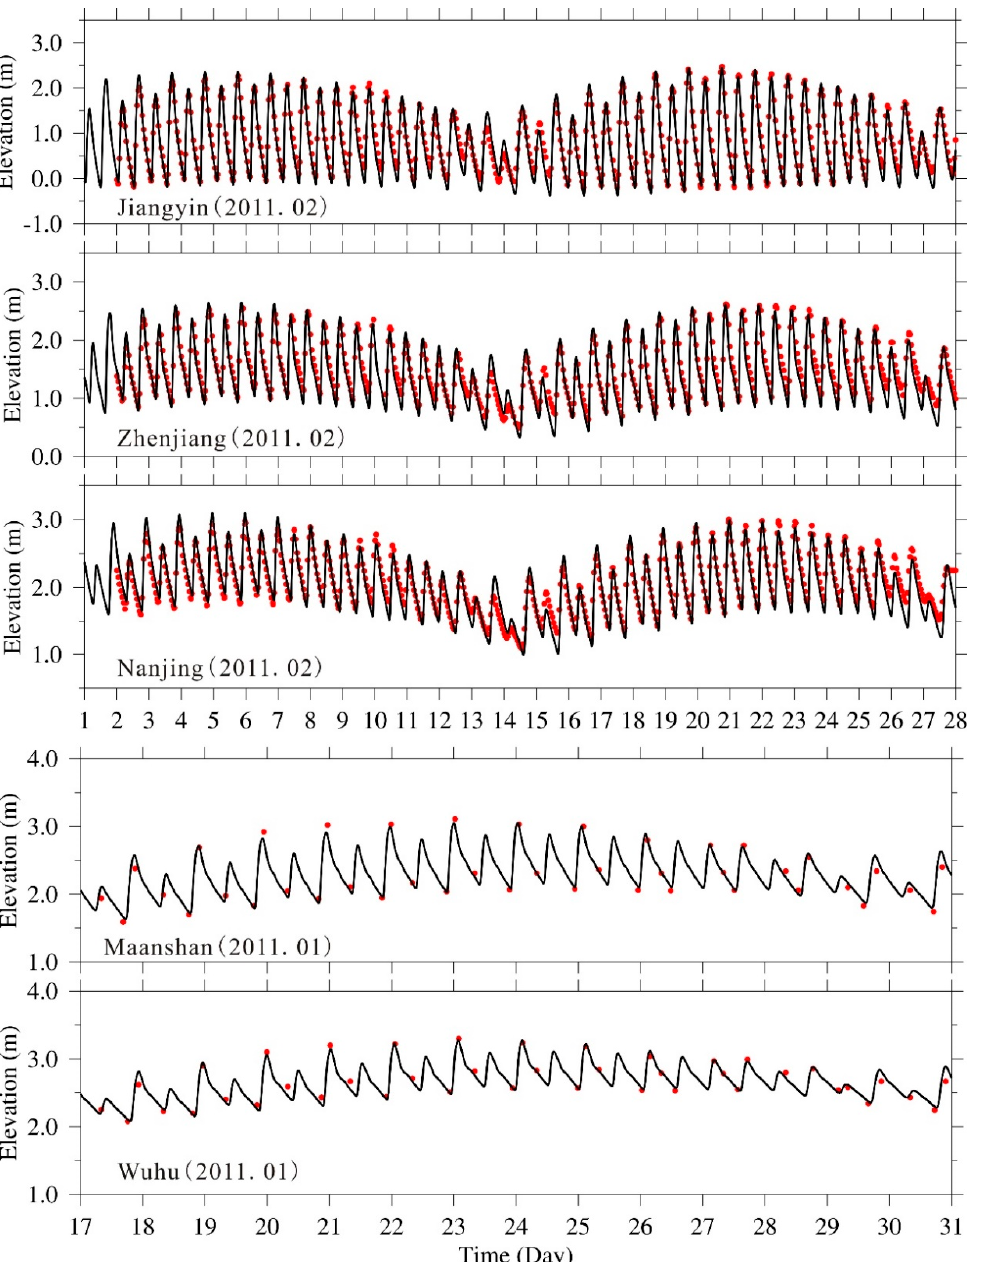
Figure 3. Temporal variation in the water level at the hydrological stations in the lower reaches of the Changjiang River. The red dots are the measured values and the black lines are the modeled values.